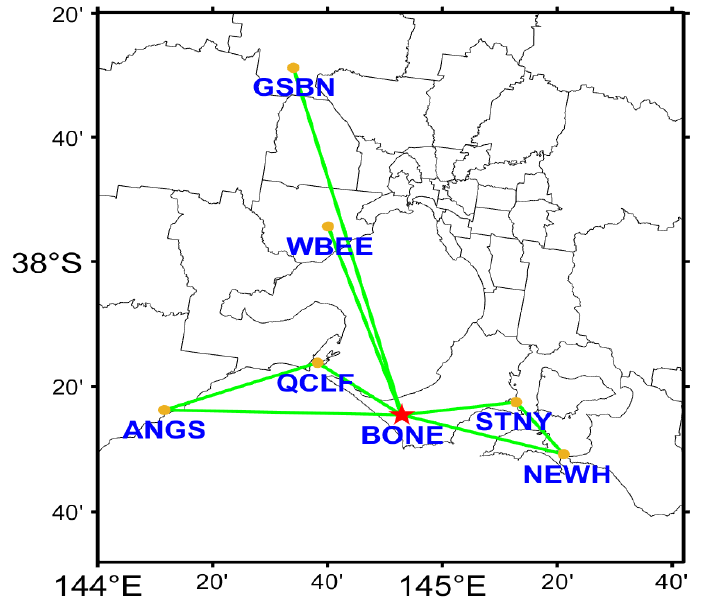
Figure 2. Distribution of CORS station BONE, QCLF, ANGS, STNY, NEWH, GSBN, WBEE. (https://gnss.ga.gov.au/network (accessed on 1 January 2021)). Table 1. Information for different baselines. Table 1. Information for different